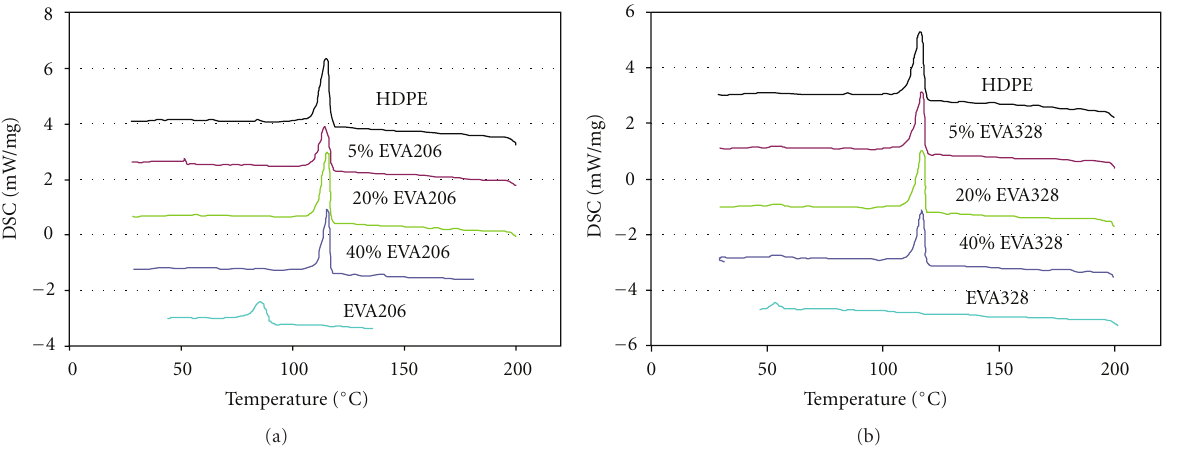
Figure 4: (a) DSC heat curves of HDPE, EVA206, and their blends. (b) DSC heat curves of HDPE, EVA328, and their blends.